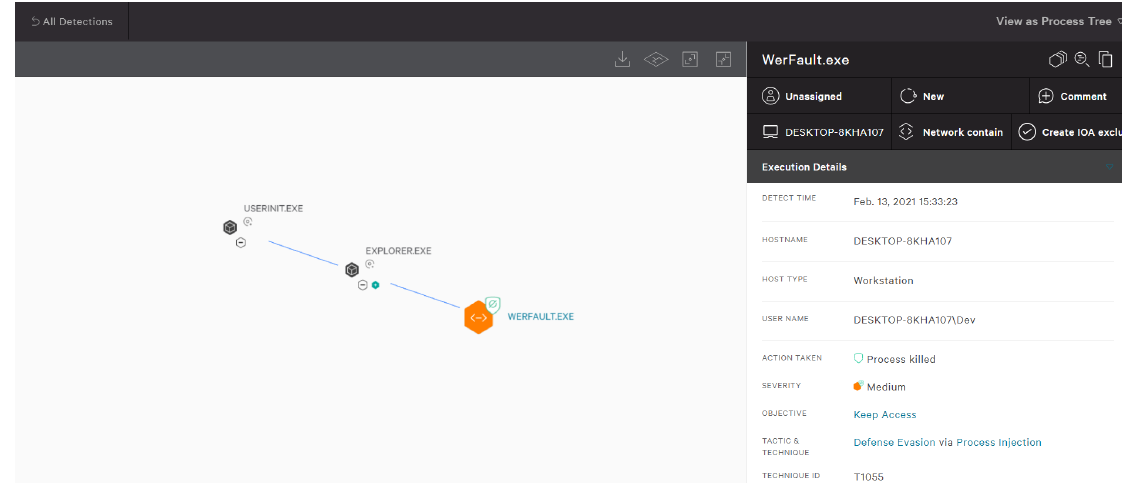
Figure 8. CrowdStrike catching the ‘Early-Bird’ injection despite the use of direct syscalls.